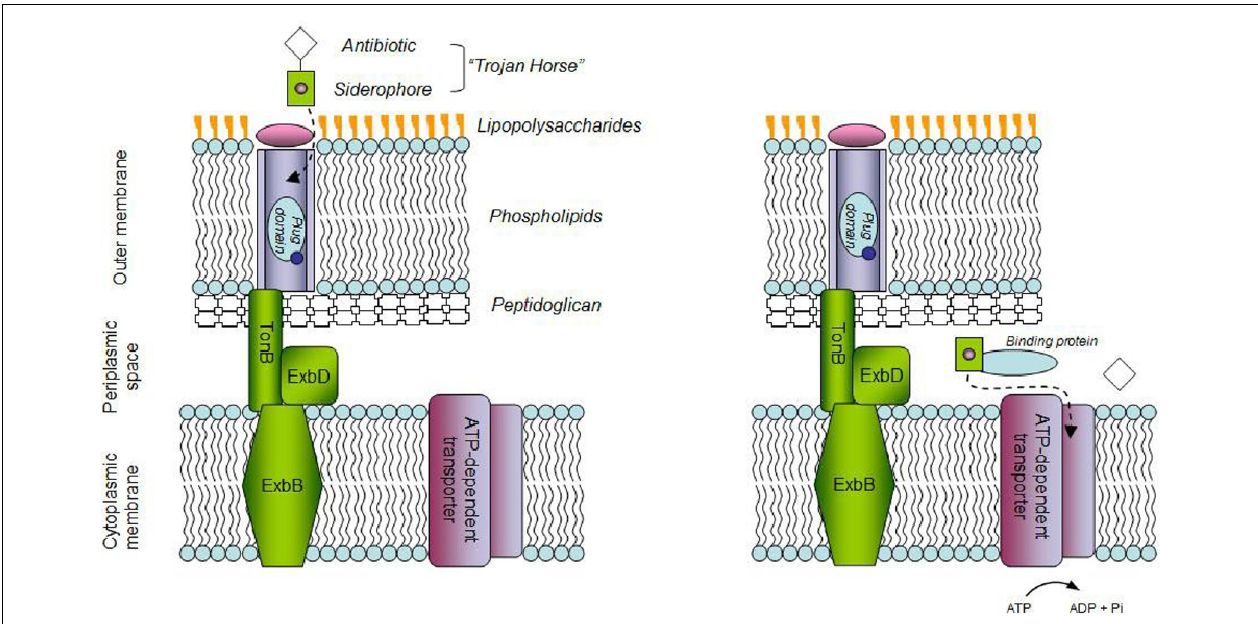
FIGURE 1 | Schematic of the “Trojan horse” strategy in Gram-negative bacteria. Antibiotic bound-siderophores bind to outer-memberane receptors which help their transport to the periplasmic space upon interaction with the Ton complex. In the periplasm,